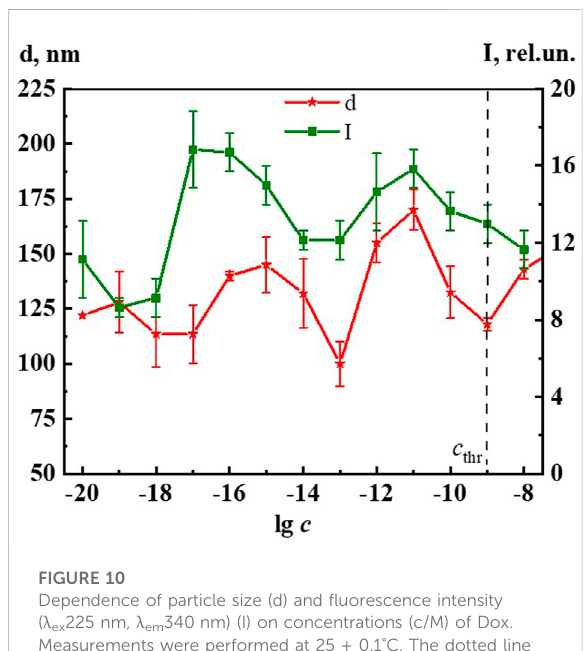
FIGURE 10 Dependence of particle size (d) and fl uorescence intensity ( λ ex 225 nm, λ em 340 nm) (I) on concentrations (c/M) of Dox. Measurements were performed at 25 ± 0.1 ° C. The dotted line indicates the threshold concentration ( c thr